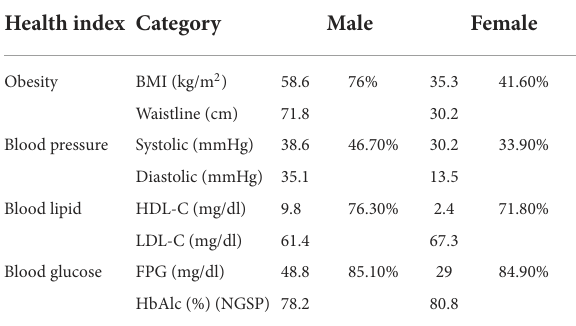
TABLE 1 Health condition of all participants in SLS program in